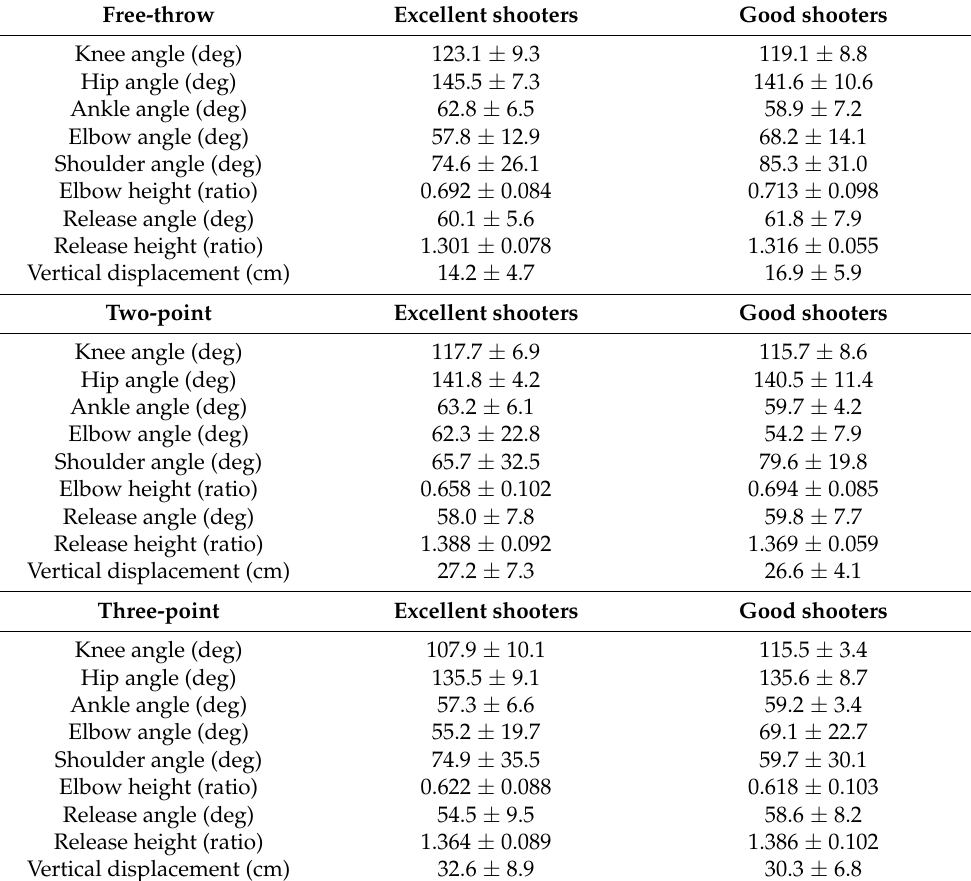
Table 2. Descriptive statistics, means and standard deviations (x ± SD), for each dependent variable observed for excellent ( ≥ 80%; n = 6) and good (<80%; n = 4) free-throw, two-point, and three-point shooters. Free-throw Excellent